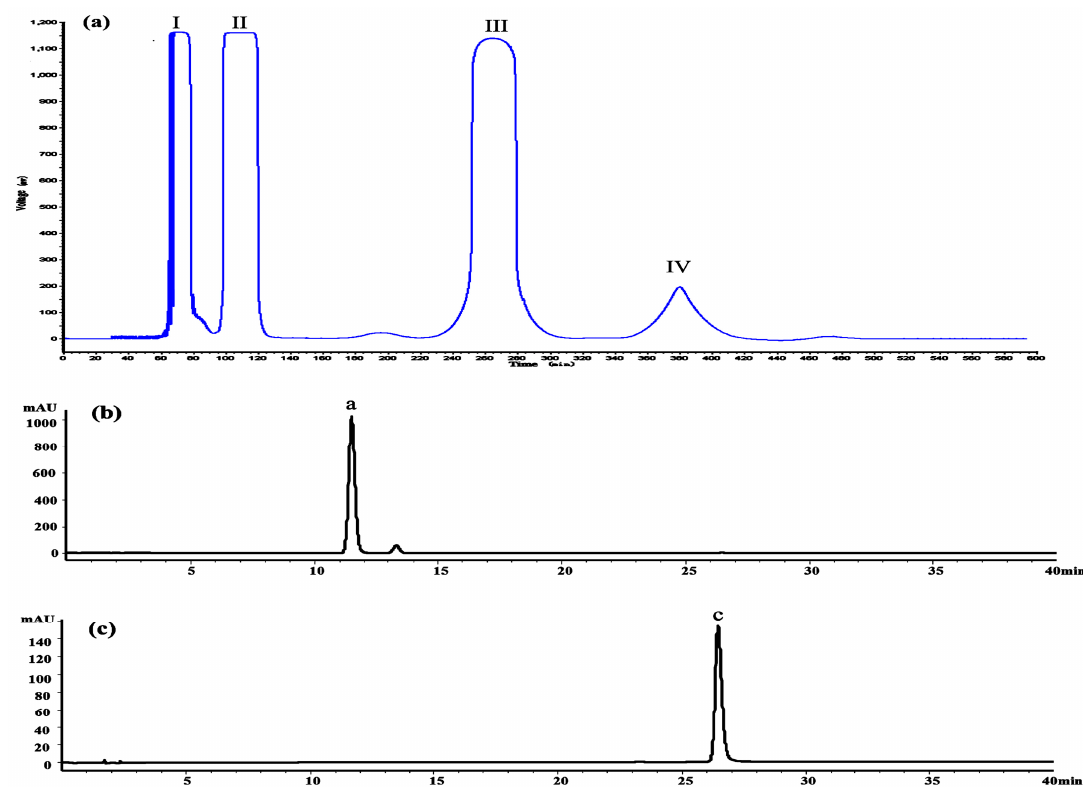
Figure 8. High-speed counter-current chromatography (HSCCC) chromatogram of the extracts of Ampelopsis grossedentata ( a ); two-phase solvent system: N -hexane–ethyl acetate–methanol–water (1:3:2:4, v / v/v / v ); stationary phase: upper organic phase; mobile phase, lower aqueous phase; flow-rate: 2.0 mL/min; revolution: 800 rpm; detection wavelength: 254 nm; retention of stationary phase: 58%. HPLC chromatograms of HSCCC peak fractions, peaks of III in ( b ) dihydromyricetin, peaks of IV in ( c ) myricetin.